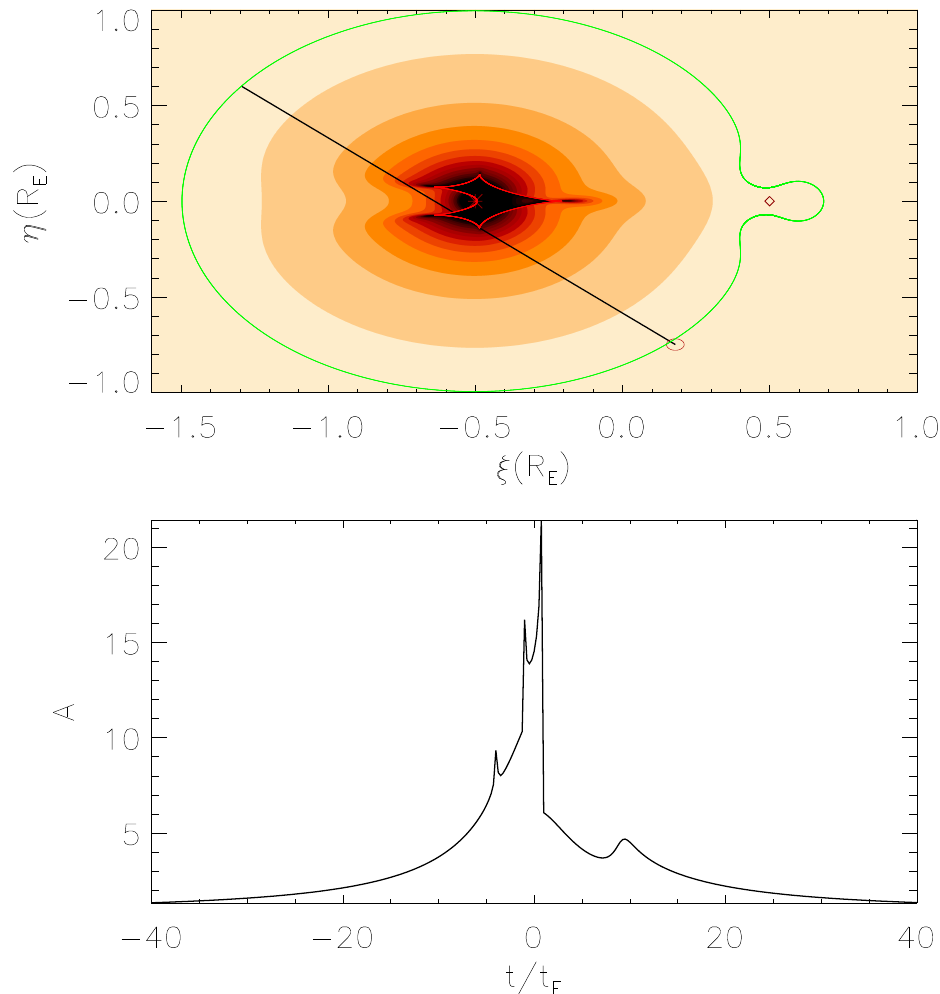
Figure 4. Magnification map for a binary lens system characterized by two objects separated by a projected distance of 1 R E and mass ratio q = 0.01. The green and red closed lines indicate the critical and caustic curves obtained by solving the lens equation in Equation (1). The black line indicates the trajectory of the source star, which has a radius of 0.03 R E . The simulated light curve is shown in the lower